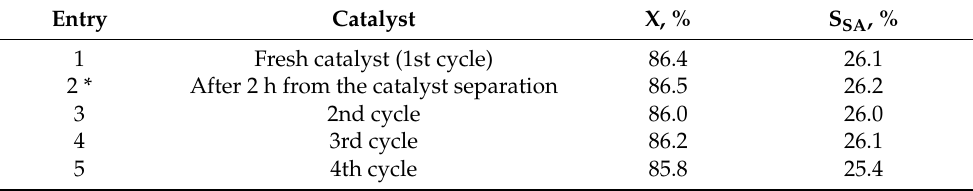
Table 4. Activity and selectivity of Nb(0.05)- β 18 catalyst in recycling tests.